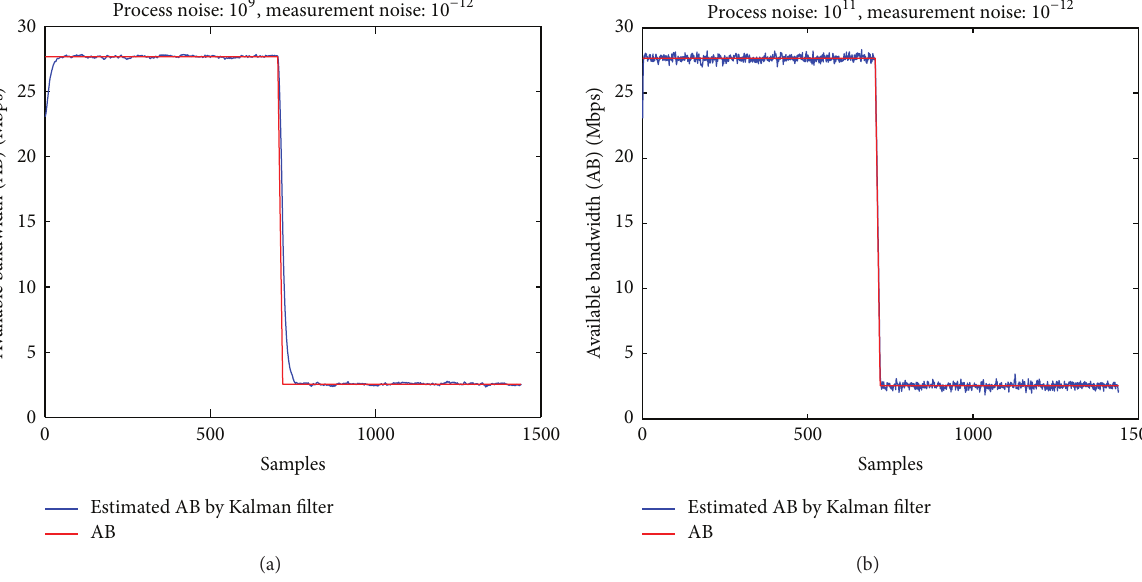
The relative errors are plotted over a plan whose axes represent the covariance matrixes of the measurement and process noise, respectively. In detail, each bar represents the percentage of errors calculated according to (12) that fall below the considered